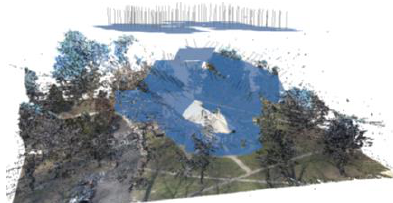
Figure 11. The real-world dataset contains 350 images. GSD: 7mm/px, Area: 844 m 2 , Mission duration: 46min.